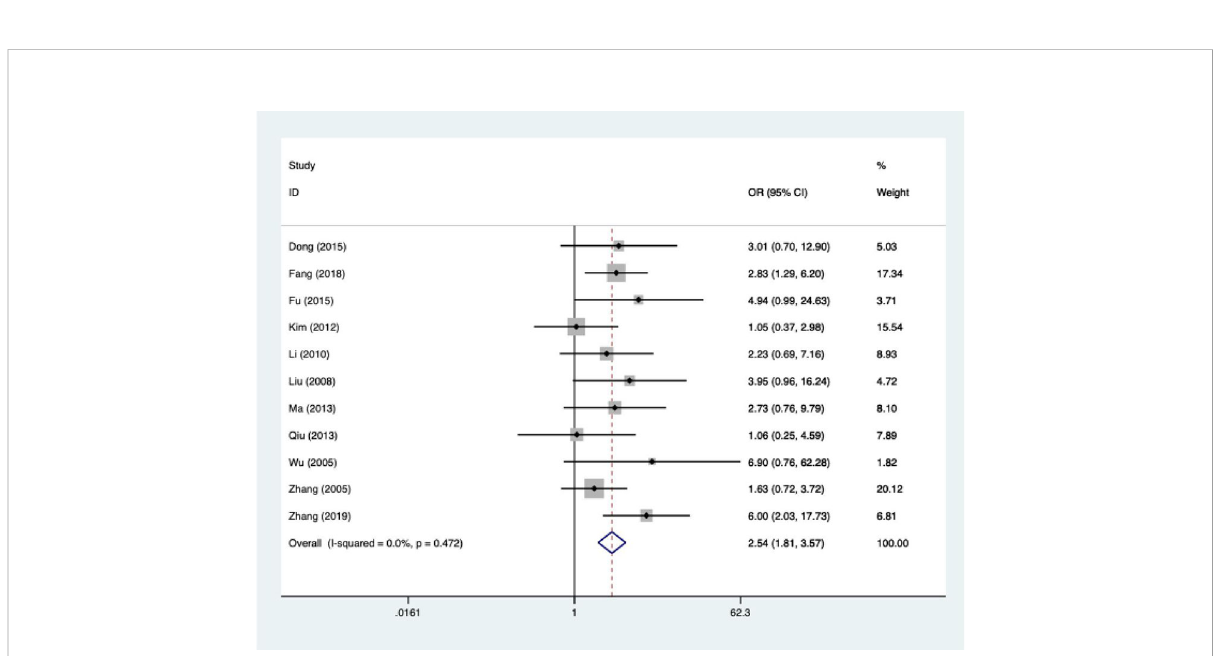
FIGURE 5 Results of heterogeneity analysis of tumor response rate.